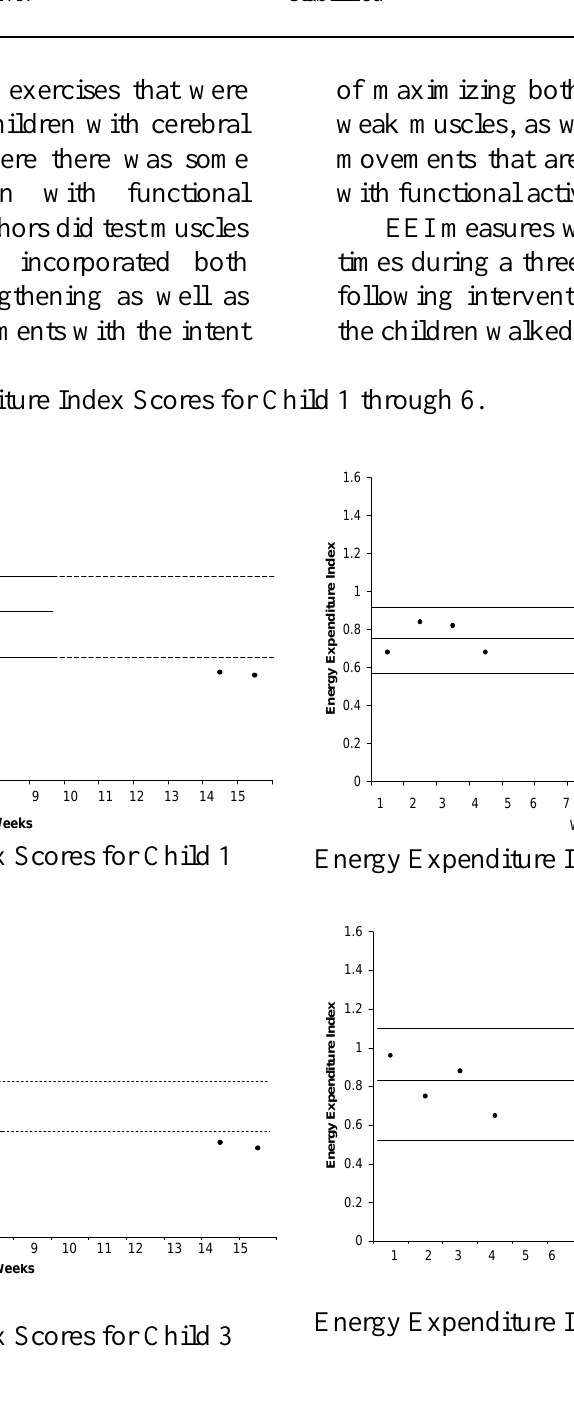
Placement Across the metatarsal lower leg stabilized heads